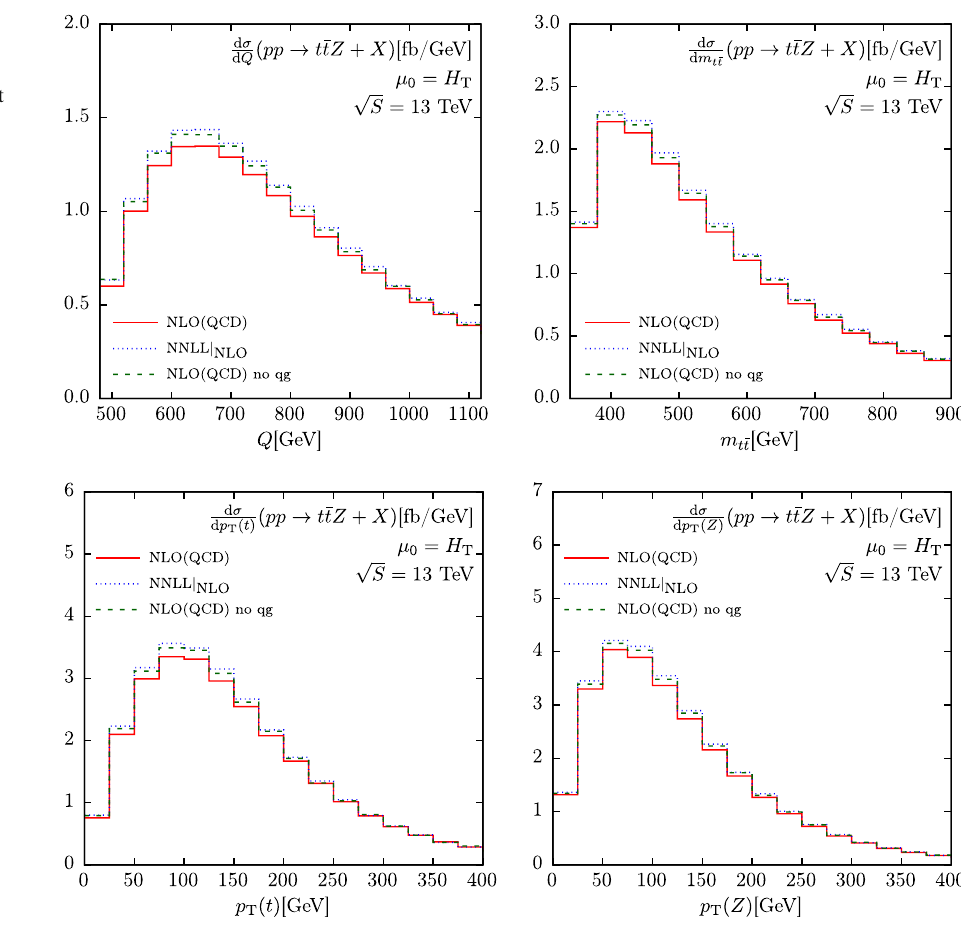
Fig. 2 Comparison between the expansion of the NNLL expression up to NLO accuracy in α s , the full NLO(QCD) result and the NLO(QCD) result without the qg channels for the pp → t ¯ tZ differential distributions in Q and m t ¯ t